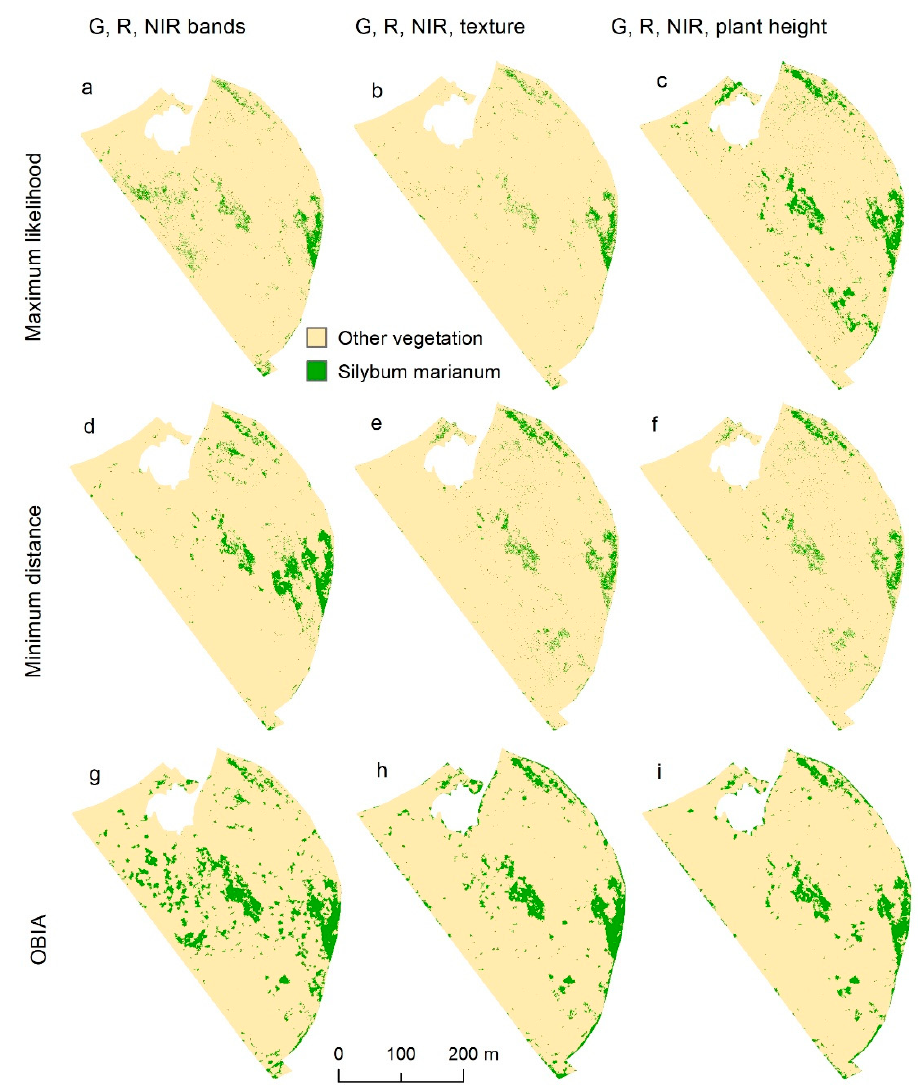
Figure 6. Weed distribution maps using three classifiers on various input layers acquired on 22 April 2016. G, R and NIR are the green, red and near-infrared bands of the UAV orthomosaic, respectively.